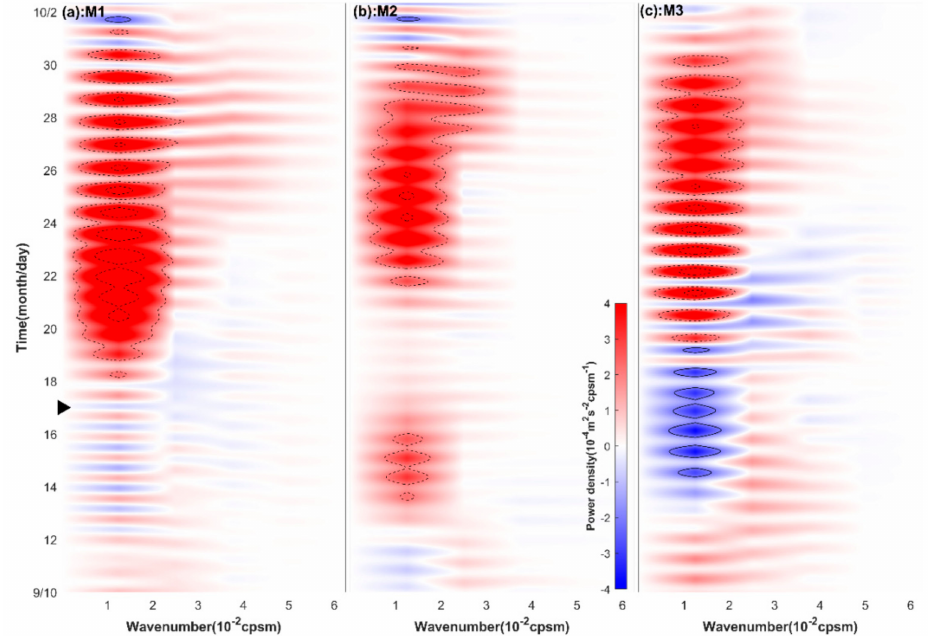
Figure 8. The rotary vertical wavenumber spectra of NIWs in M1 ( a ), M2 ( b ), and M3 ( c ). The dashed contours denote 2 × 10 − 4 and 6 × 10 − 4 m 2 s − 2 cpsm − 1 , and the solid contours denote − 2 × 10 − 4 m 2 s − 2 cpsm − 1 . The horizontal axis has units of cycles per stretched meter (cpsm), and the passage of Noul is denoted by the triangle.